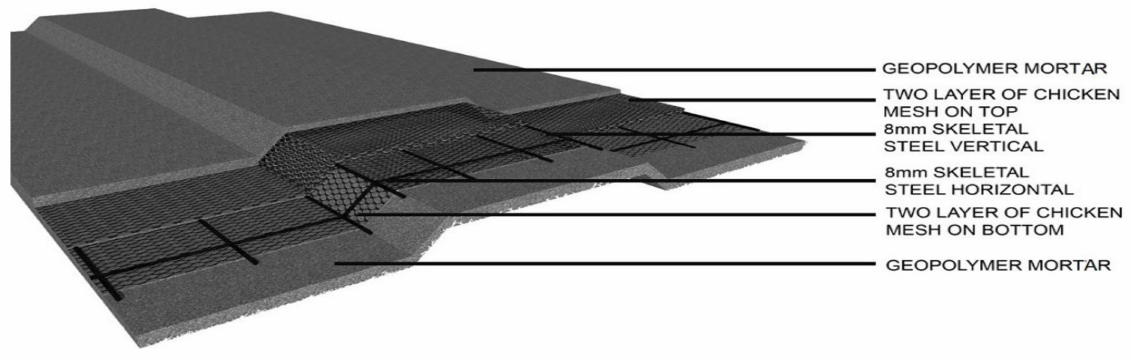
Figure 4. 3D view of the Geopolymer ferrocement